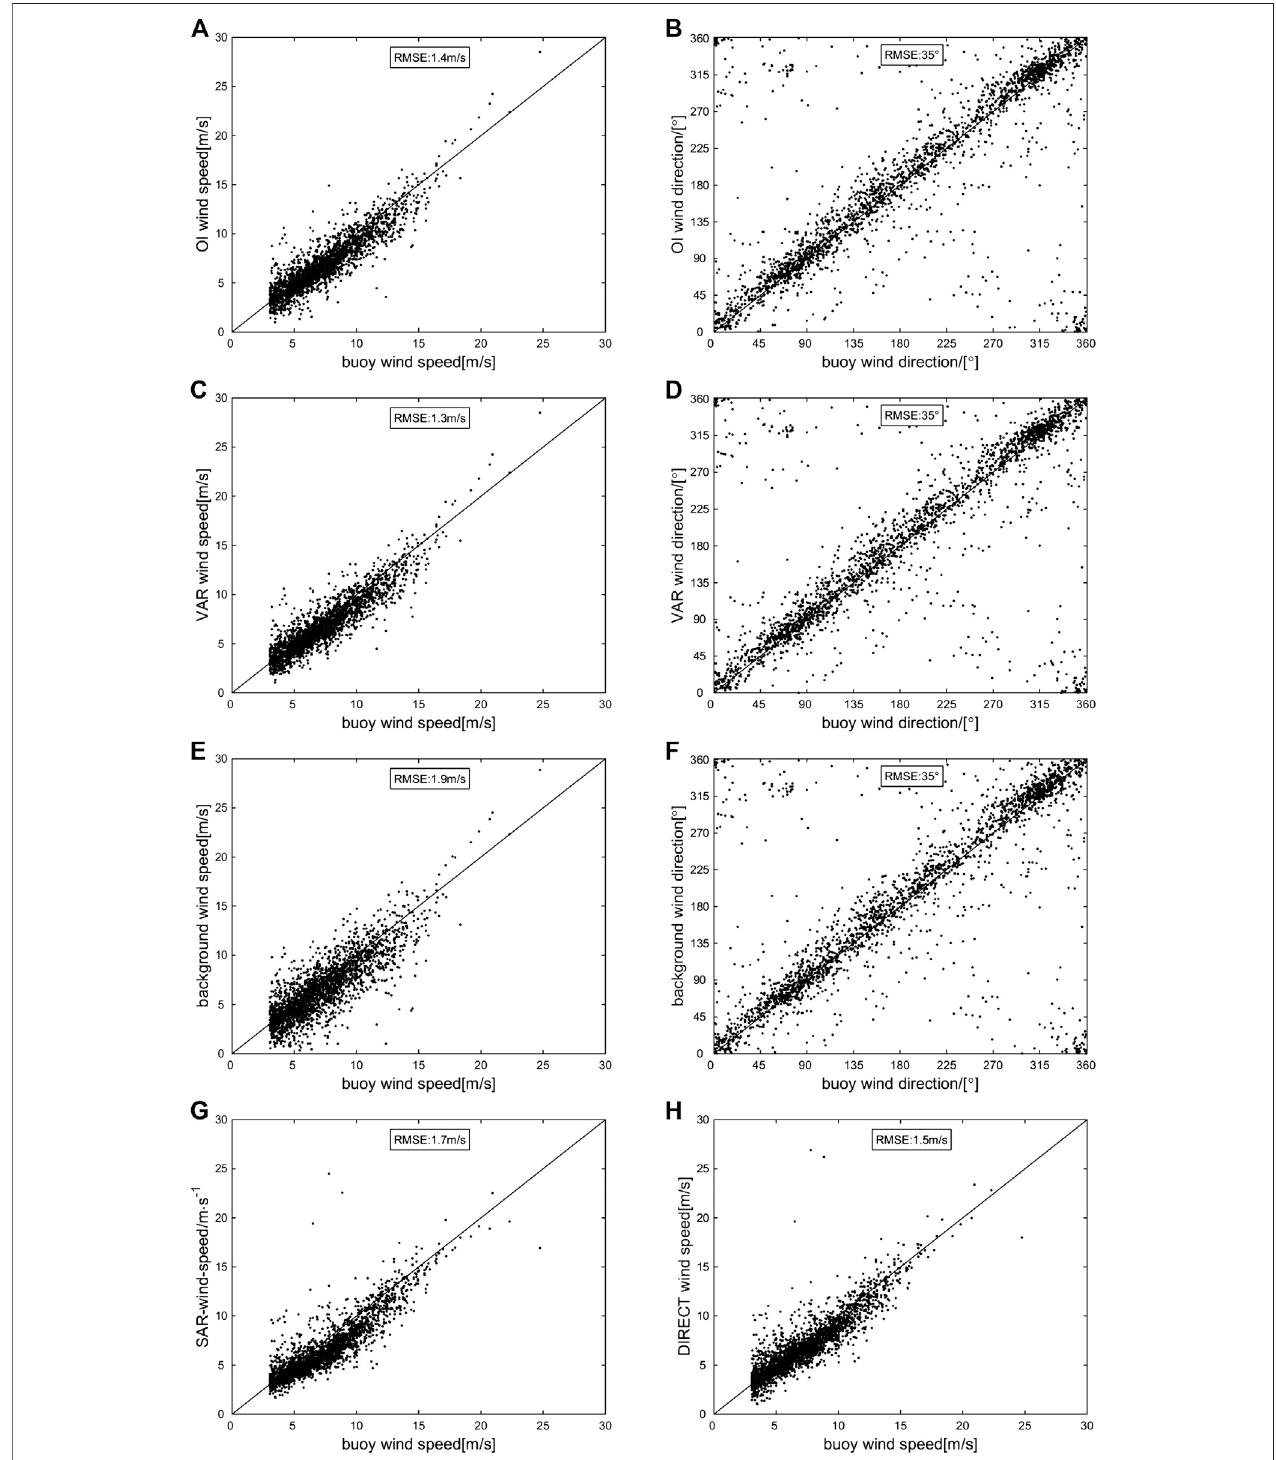
FIGURE 9 | Scatter plots of different retrieved winds against the NDBC buoy observations for wind: (A , B) OI-retrieved wind vs. the NDBC buoy observations for wind speed and wind direction, respectively; (C , D) VAR-retrieved wind vs. the NDBC buoy observations for wind speed and wind direction, respectively; (E , F) background wind vs. the NDBC buoy observations for wind speed and wind direction, respectively; (G) synthetic aperture radar-wind-speed vs. NDBC buoy observations for wind speed; (H) CMOD5 retrieved wind speed vs. NDBC buoy observations for wind speed.